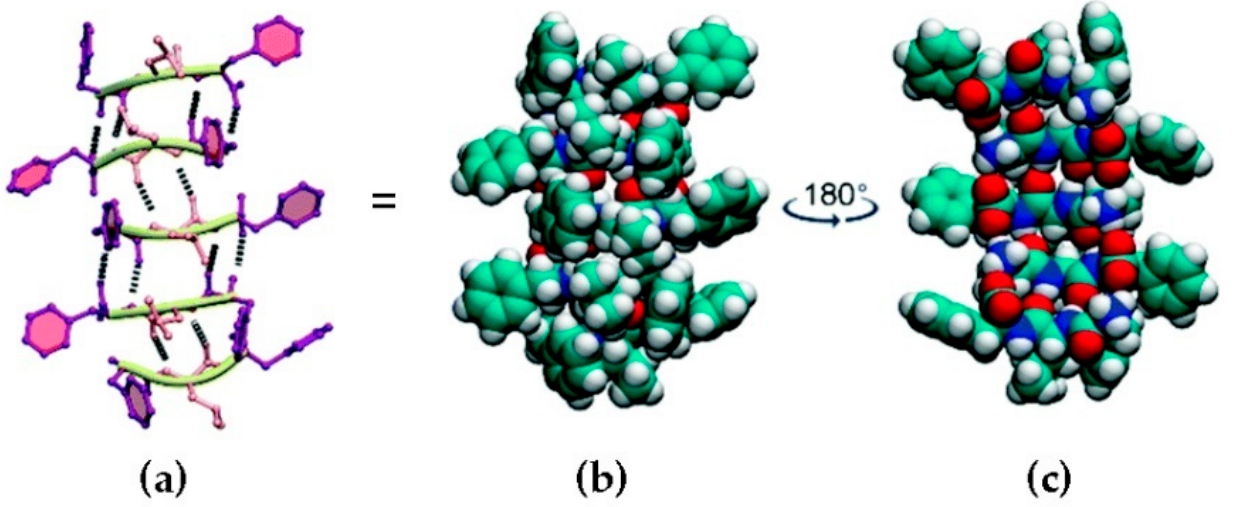
Figure 1. Heterochiral peptide self-assembly. L -Phe- D -Leu- L -Phe forms stacks held together by H-bonding between amides ( a ), and space-fill representations ( b , c ) show the amphipathic character of the stacks, which display a hydrophobic face with the peptide sidechains ( b ) and a hydrophilic face with amide bonds ( c ). Carbon atoms are shown in green, hydrogen in white, nitrogen in blue, and oxygen in red. Reproduced from [45].